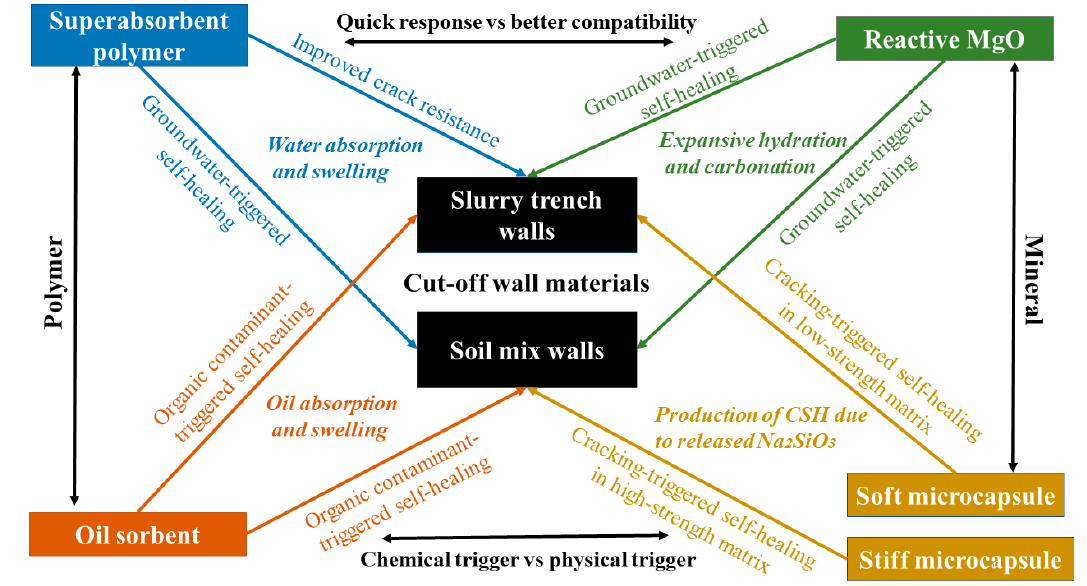
Figure 2. Schematic of work carried out at Cambridge on different polymer and mineral additives in slurry trench and soil mix barrier materials.